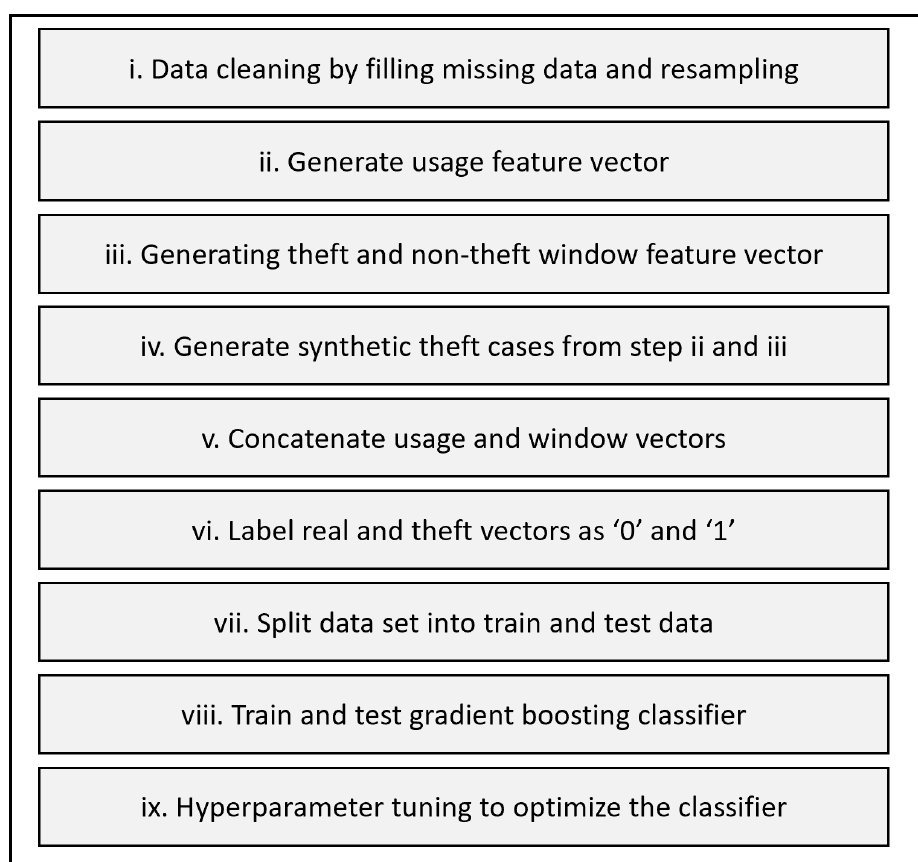
Figure 3. Schematic diagram of the DETD algorithm.